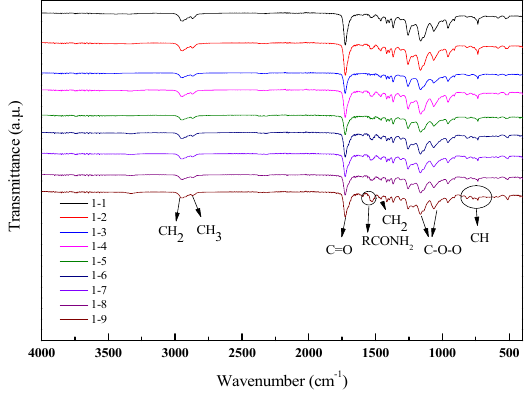
Figure 4. FTIR spectra of polyester-based TPUs.